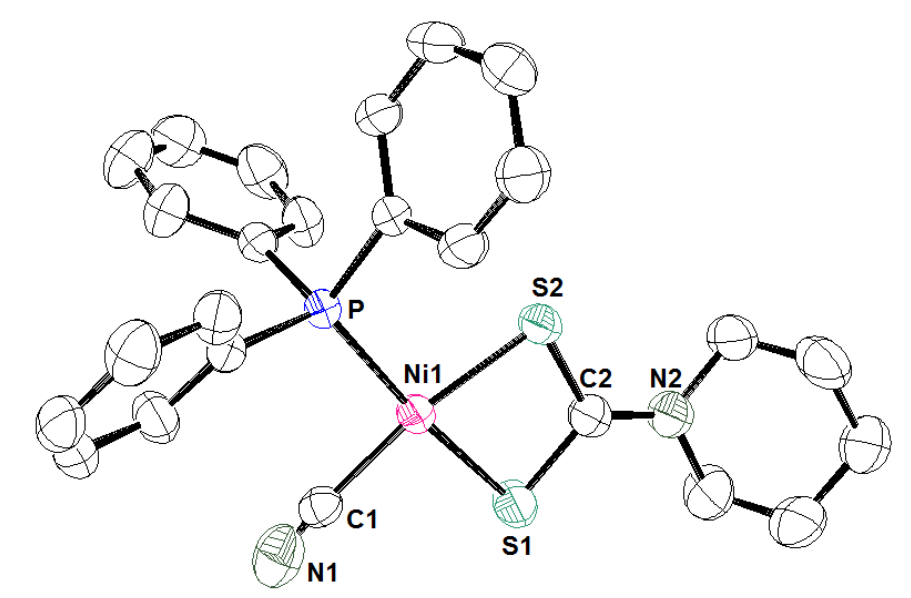
)(CN)] (3) (Hydrogens are excluded; Ellipses are of 50% probability). 3